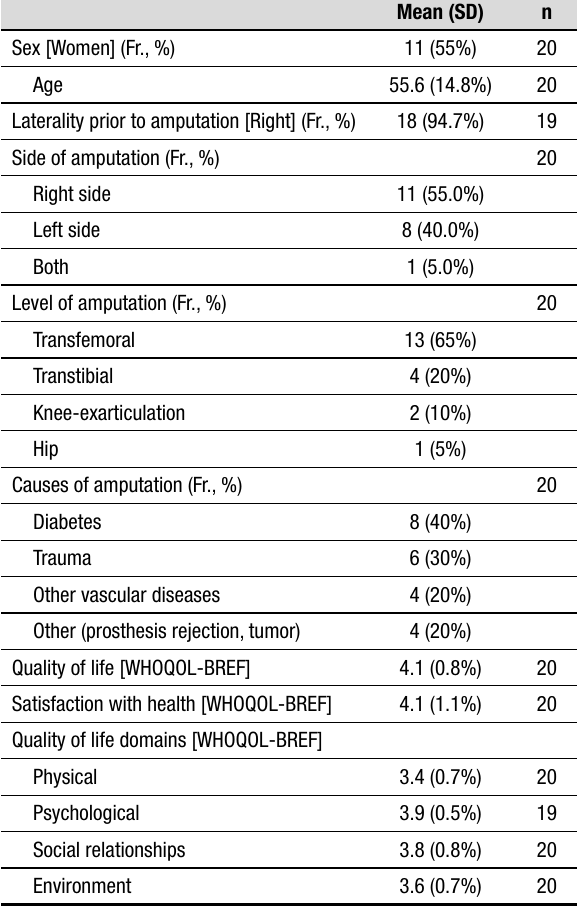
Table 1. Demographics, level of amputation, and quality of life according to the World Health Organization Quality of Life-Bref questionnaire among lower-limb amputees